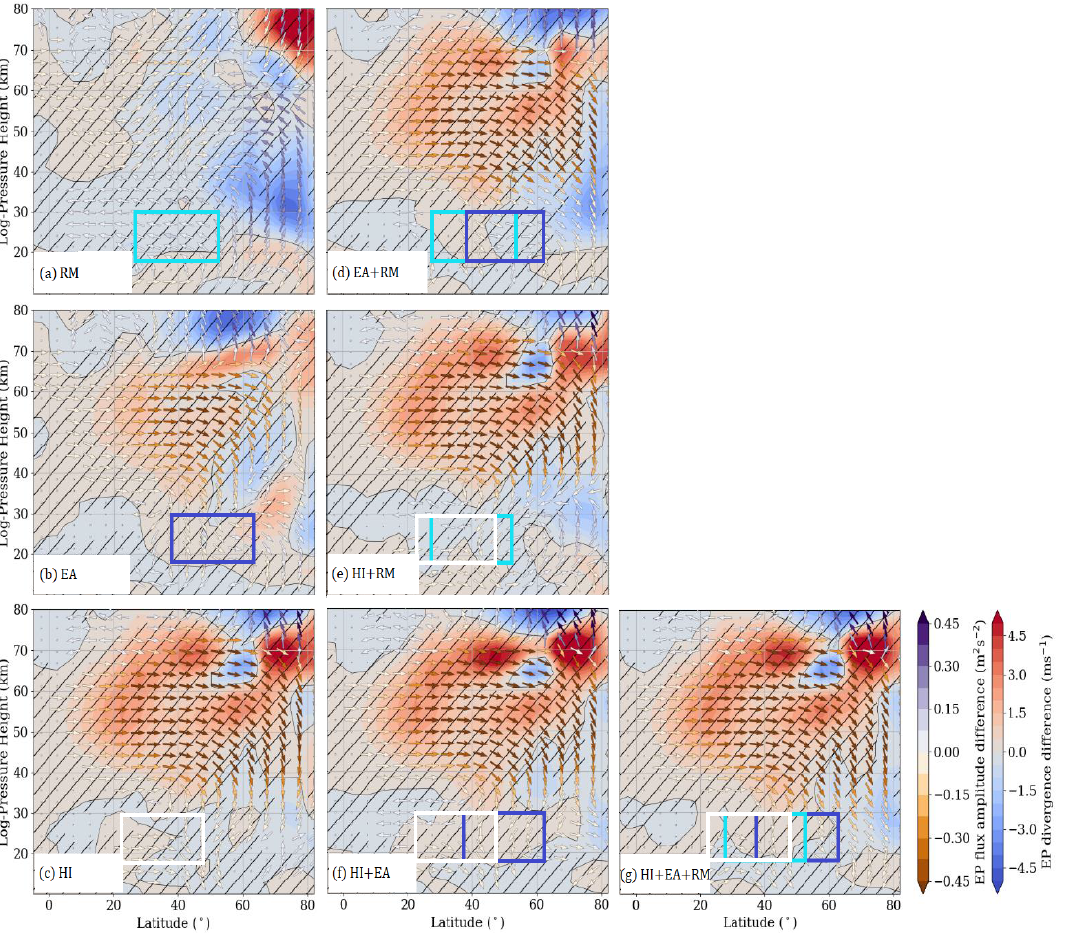
Figure 10. Colored shaded areas: EP flux and EP flux divergence differences of the SPW 1 between each experiment and the Ref simulation. The left column shows the RM ( a ), EA ( b ) and HI ( c ) GW hotspots. The middle column shows the RM + EA ( d ), RM + HI ( e ) and HI + EA ( f ) GW hotspots. The right column shows the RM + HI + EA GW hotspots ( g ). The color coding indicates the EP divergence differences; the zero line is highlighted. Areas of negative EP divergence in the Ref simulation are hatched. The arrows represent the changes in direction and strength of the EP flux between the respective experiment and the Ref simulation. The arrows were replaced by dots when the EP amplitude difference was smaller than 1% of the maximum EP flux amplitude